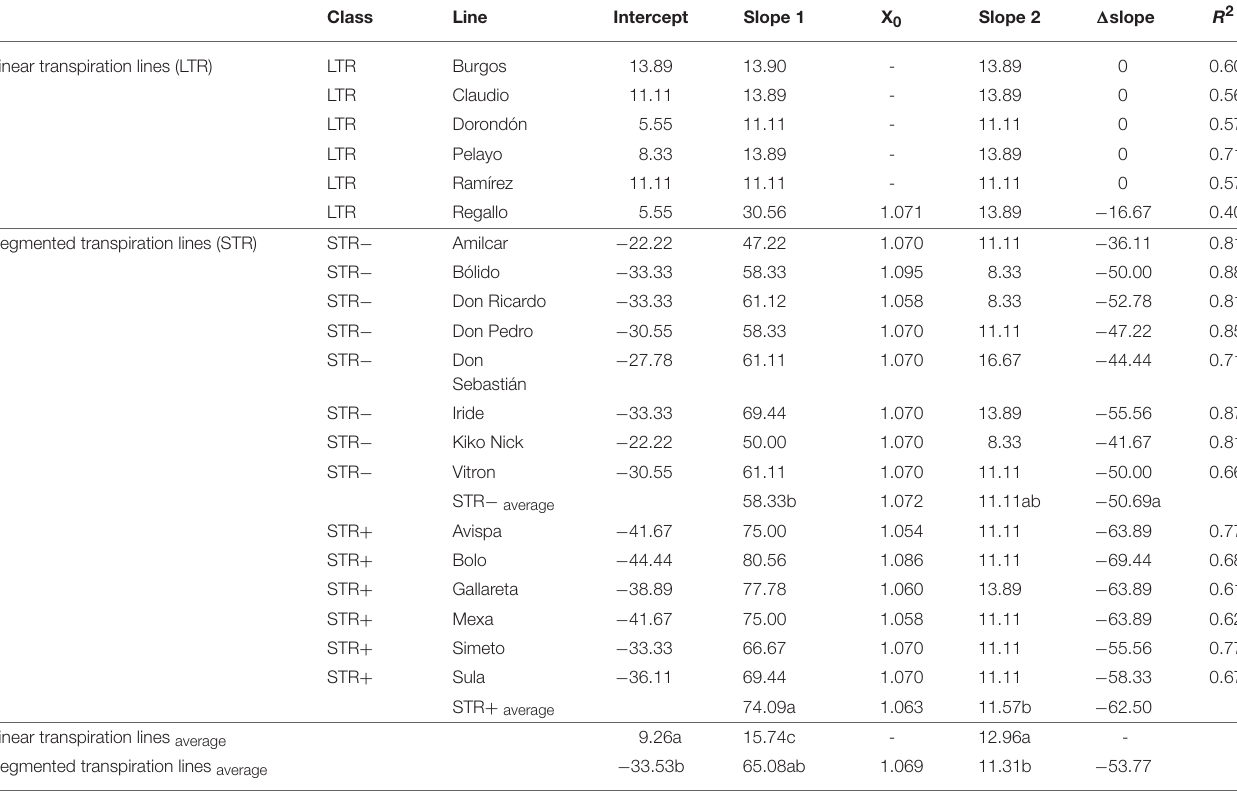
TABLE 3 | Transpiration response to variations in vapor pressure deficit (VPD) of 20 durum wheat